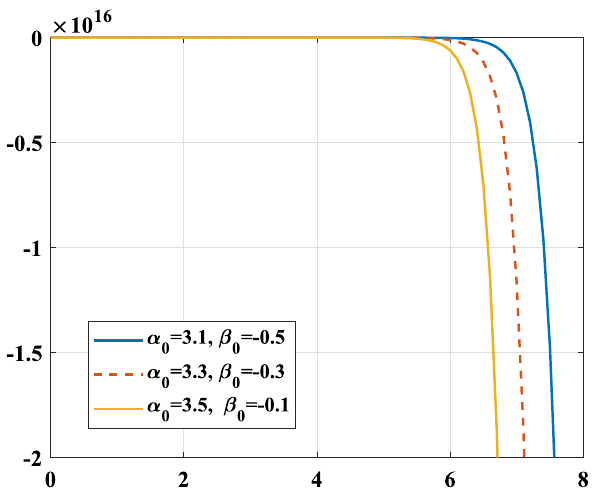
Fig. 15 Plot of v 2 s versus time ( t ) for k = 1 . 9, α 1 = 1 . 2, α 2 = 0 . 52, and γ 1 =